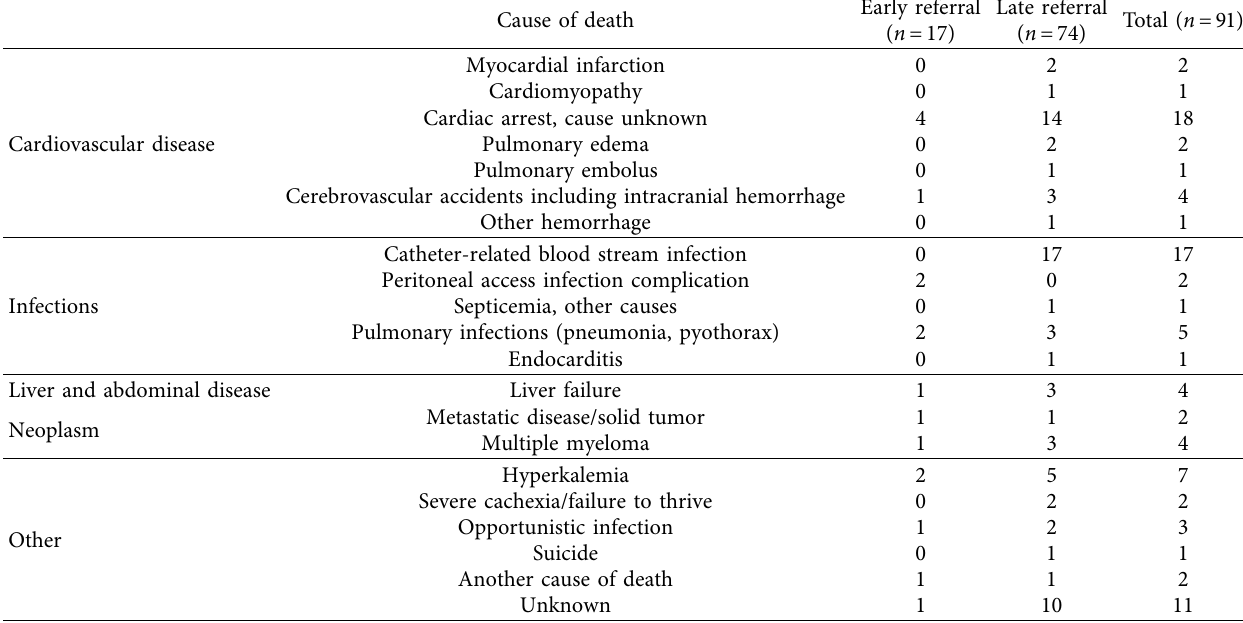
Table 6: Cause of death in patients on follow-up in early and late referral group.